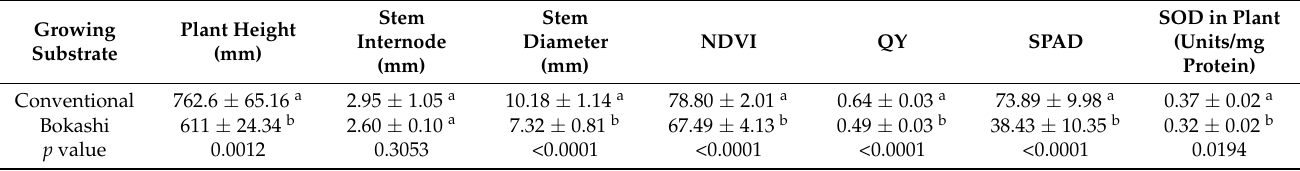
Table 2. Effects of conventional and bokashi hydroponics on vegetative growth parameters (plant height, stem diameter, stem internode length), photosynthetic performance (NDVI, QY and SPAD). Growing